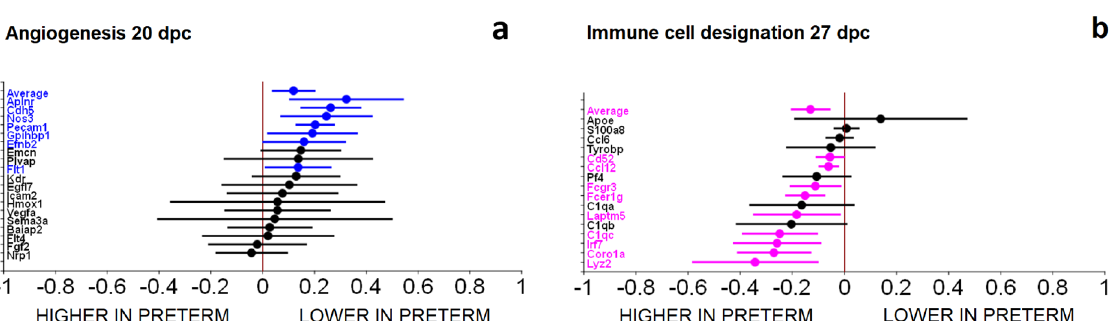
Figure 4. Angiogenesis at 20 dpc and immune cell designation at 27 dpc were the top differential gene expression pathways. At 20 dpc, differential gene expression of seven (gene names highlighted in red) out of 19 genes with confidence intervals (CI) indicating lower gene expression in the preterm group as compared to the term group were observed in the angiogenesis pathway ( a ). At 27 dpc, the category of immune cell designation showed nine of the sixteen genes that had CI’s with higher gene expression in the preterm group compared to the term group ( b Agt ) that had higher expression in the preterm group. None of the differences in individual genes reached statis- tical significance using the adjusted p < 0.05. At 27 dpc, the top three pathways of differently expressed genes included immune cell designation (Fig. 4b), proximal tubule, and renin-angiotensin pathway. The category of immune cell designation and nine of the sixteen genes within this pathway had CI’s that indicated higher gene expression in the preterm group ( Cd52, Ccl12, Fcgr3, Fcer1g, Laptm5, C1qc, Irf7, Coro1a, Lyz2 ) compared to the term group. However, none of the individual